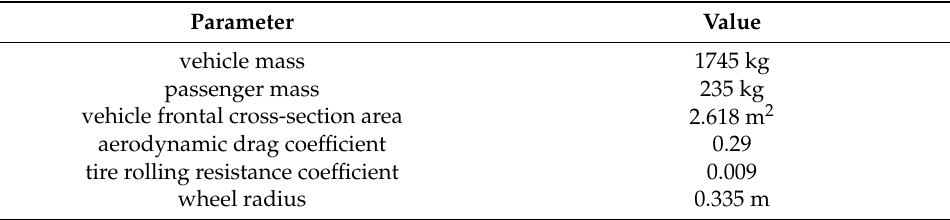
Table 1. Characteristics of the vehicle. Parameter Value vehicle mass 1745 kg passenger mass 235 kg vehicle frontal cross-section area aerodynamic drag coefficient